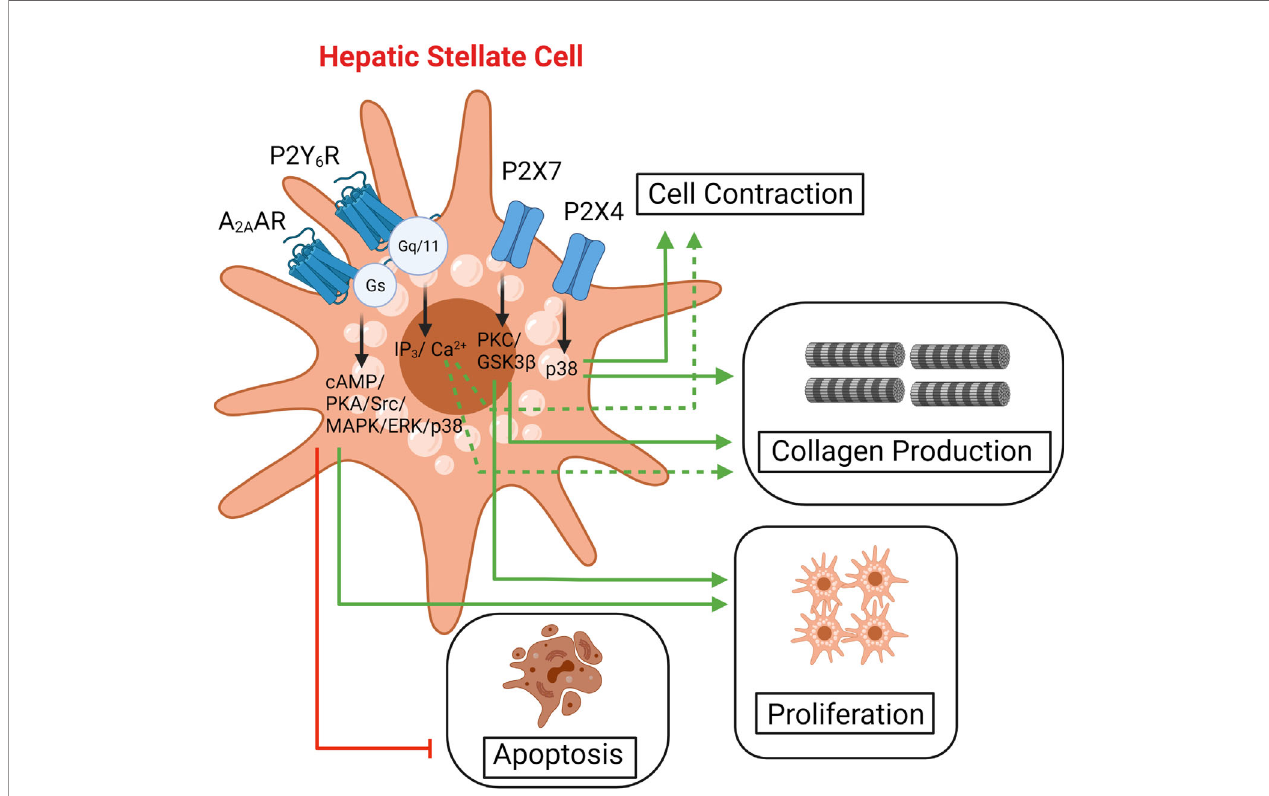
FIGURE 3 | Purinergic signaling in hepatic stellate cells. Hepatic stellate cells (HSC) are classi fi ed as non-parenchymal cells of the liver. HSC activation and proliferation results in the secretion of extracellular matrix causing liver fi brosis. Purinergic receptors are expressed in HSC and regulate key processes associated with the initiation and progression of liver fi